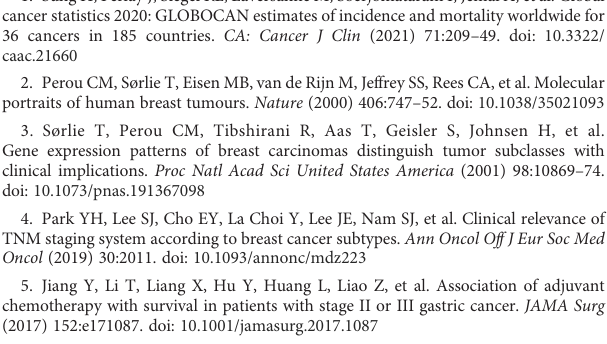
SUPPLEMENTARY TABLE 1 Summary of senescence related gene sets and genes SUPPLEMENTARY TABLE 2 278 OS-correlated senescence-high related genes and 37 Sindex